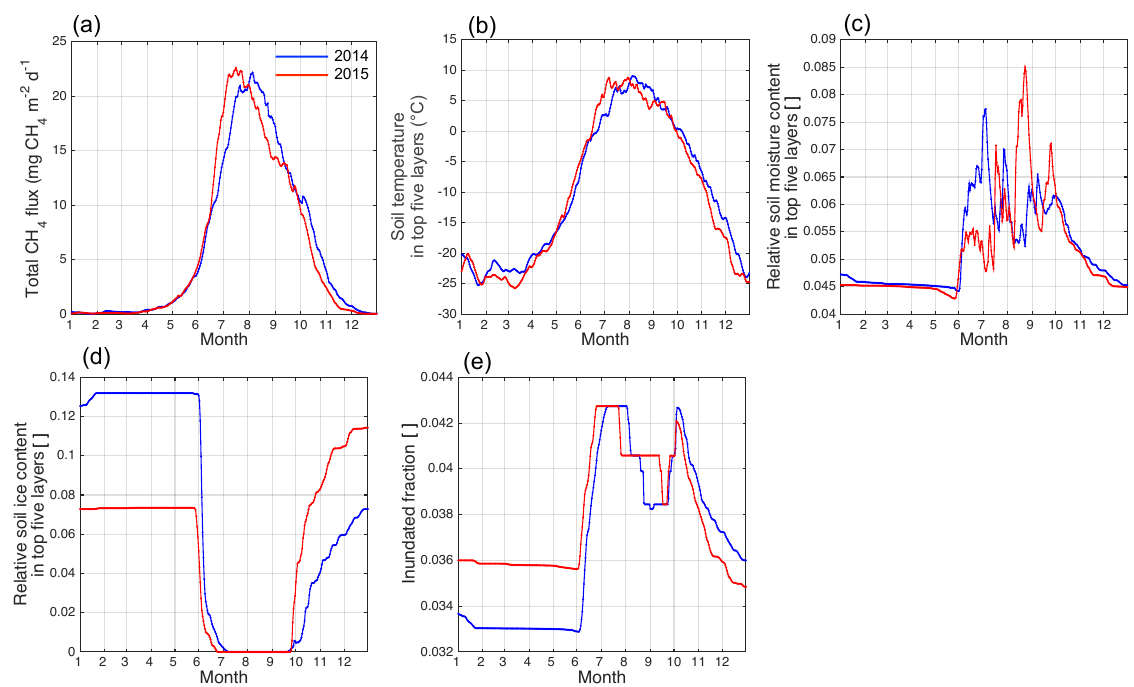
Figure 11. Time series of the daily mean of methane emissions through snow from EC measurements and model data for grid cells A and B during (a) October 2014 to March 2015 and (c) October 2015; the difference between grid cells A and B and the EC data are shown in panels (b) and (d) for the same period of time; (e) cumulative CH 4 emissions for the period from the end of autumn in 2014 until the end of spring in 2015 for the same data sets. Error bars in each data set are the standard deviation of the monthly accumulated